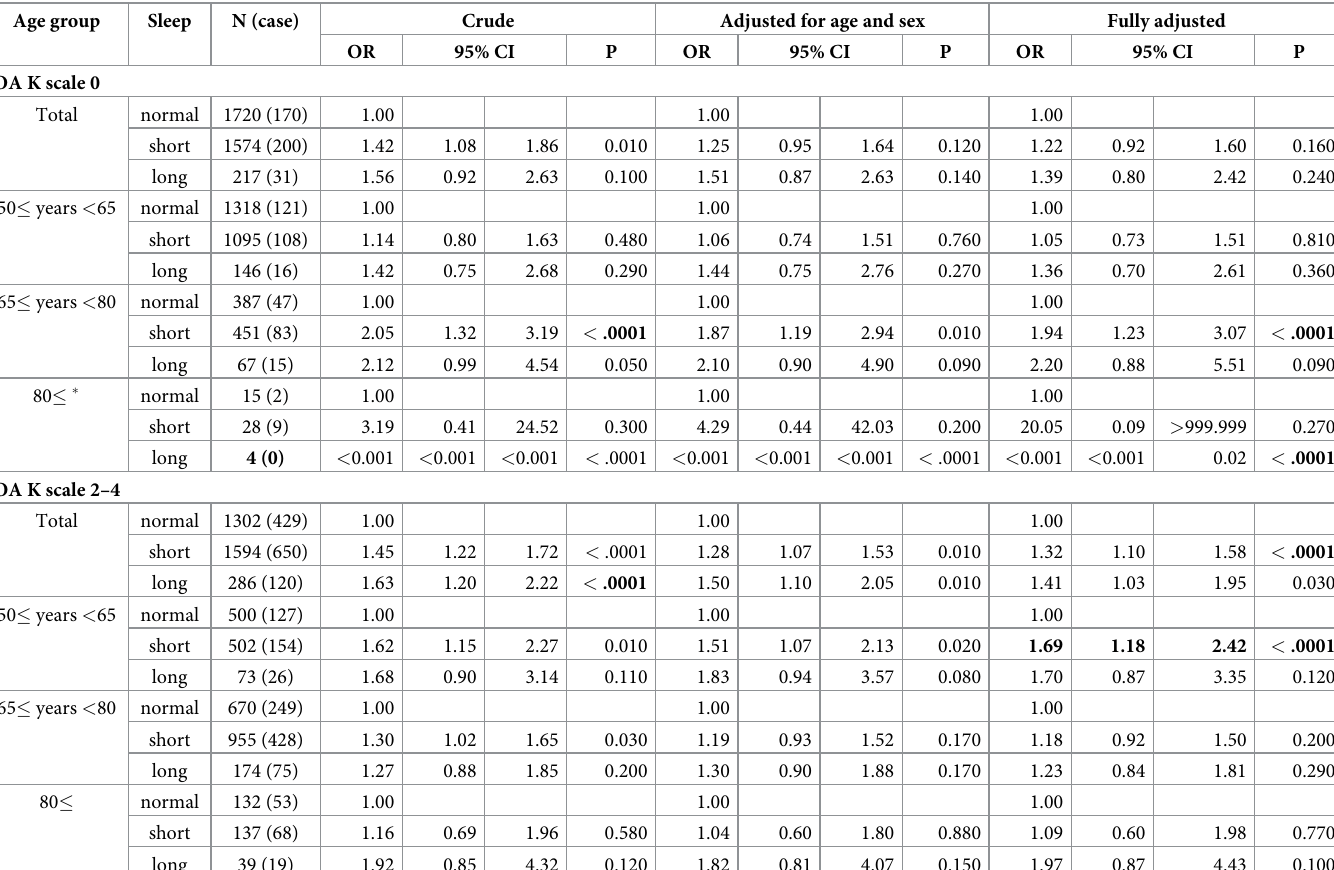
Table 6. Relationship between sleep time duration and joint pain in adults aged � 50 years, by knee joint KL grade according to age group.